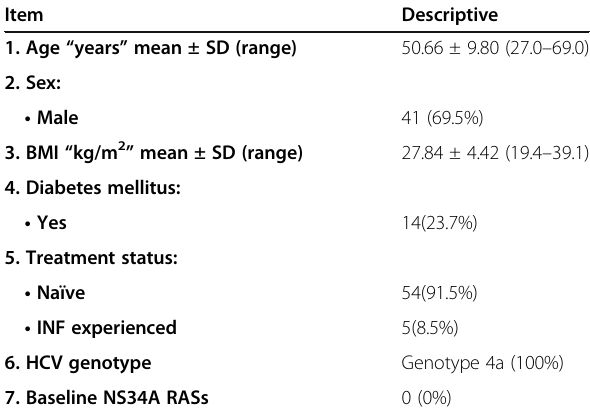
Table 1 Demographic and baseline data of the study group Item